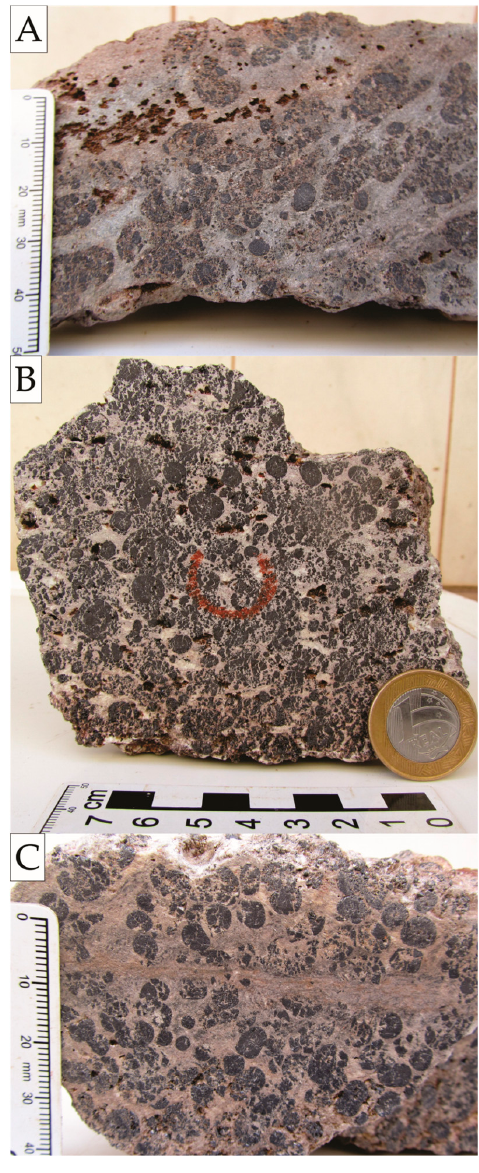
Figure 4. Hand samples of the analyzed chromitites displaying massive to intensely fractured orbs of chromite immersed in a silicate matrix. Apparent porosity is mostly due to mechanical ablation of